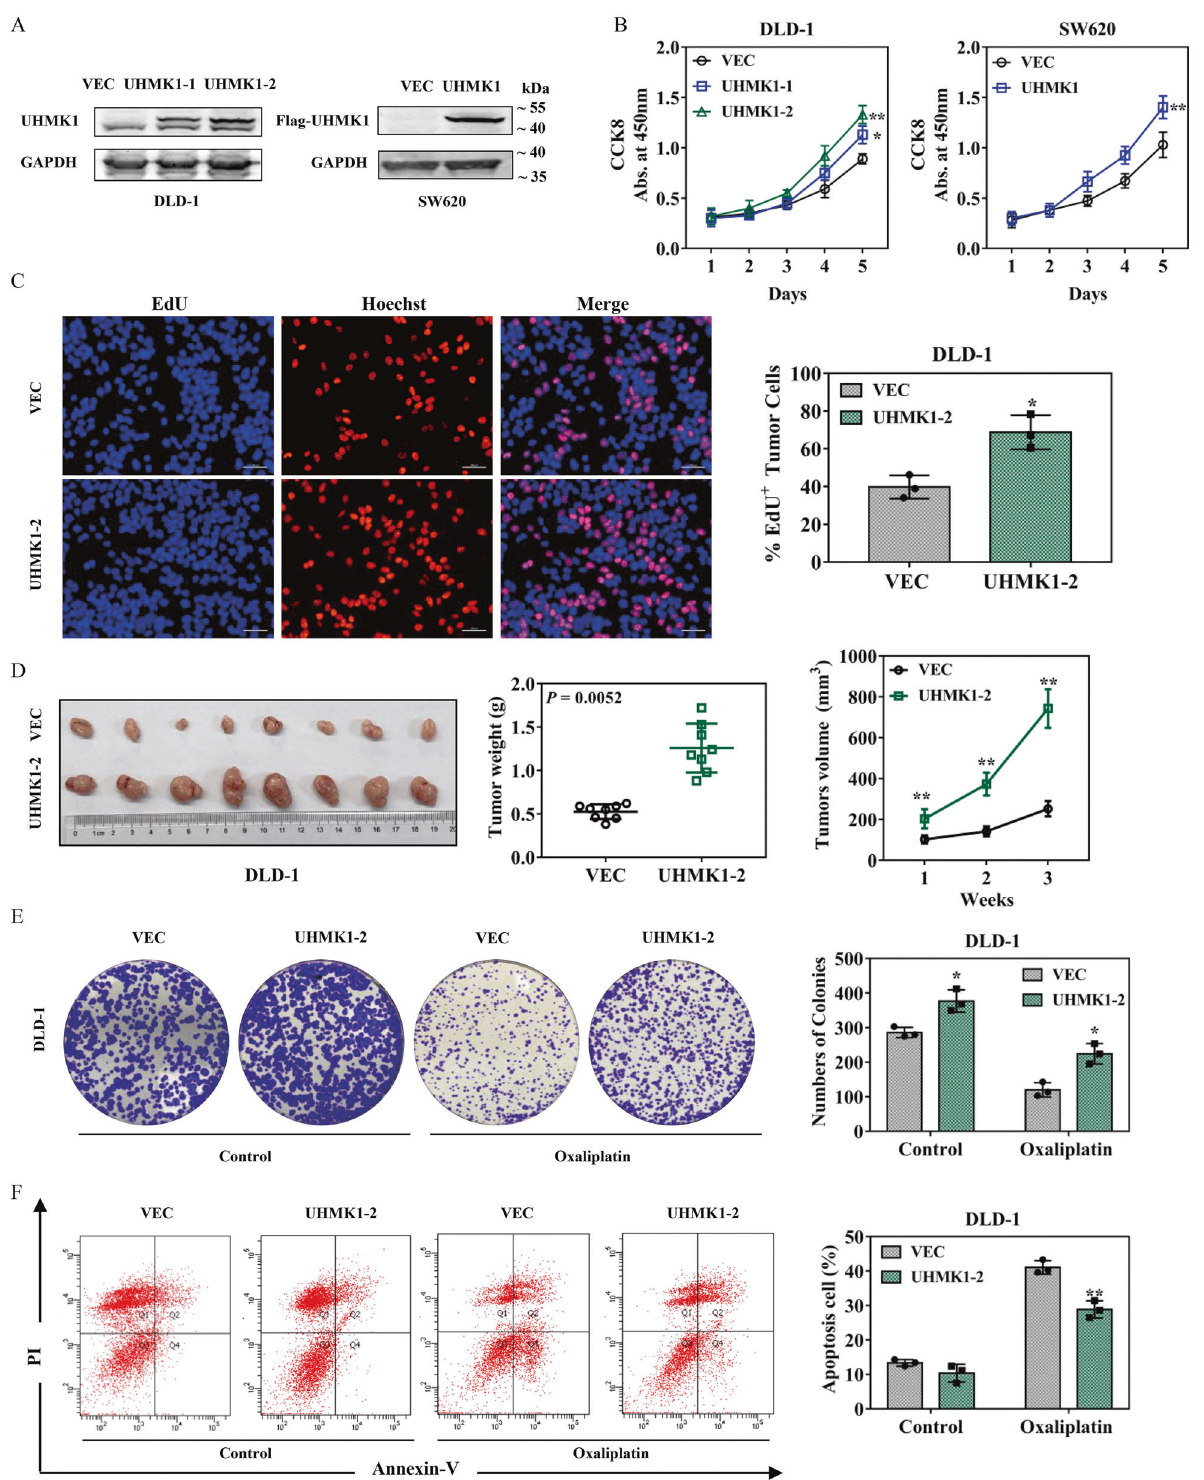
Fig. 3 The effects of UHMK1 upregulation on CRC cell proliferation, tumorigenicity and oxaliplatin resistance. A Western blot results of UHMK1 overexpression in DLD-1 and SW620 cells. Anti-UHMK1 (left) and anti-FLAG (right) antibodies were used. B The growth rates of DLD-1 and SW620 cells with or without UHMK1 overexpression were monitored by CCK-8 assay. C EdU staining was used to detect cell proliferation in DLD-1 cells with UHMK1 stable overexpression and control cells. The number of positive EdU cells was recorded. Scale bar: 100 μ m. D The image of tumors removed from nude mice implanted with DLD-1/UHMK1-2 cells ( n = 8) and control RKO cells ( n = 8) for 3 weeks. Tumor weight and tumor volume were analyzed compared to control group. E Colony formation assays in UHMK1 stably overexpressed DLD-1 cells and control cells with or without oxaliplatin treatment (100 μ M). F FACS analysis of apoptotic DLD-1 cells with or without oxaliplatin treatment (300 μ M). UHMK1 stable expression cells had an anti-apoptosis effect. * p < 0.05, ** P < 0.01.